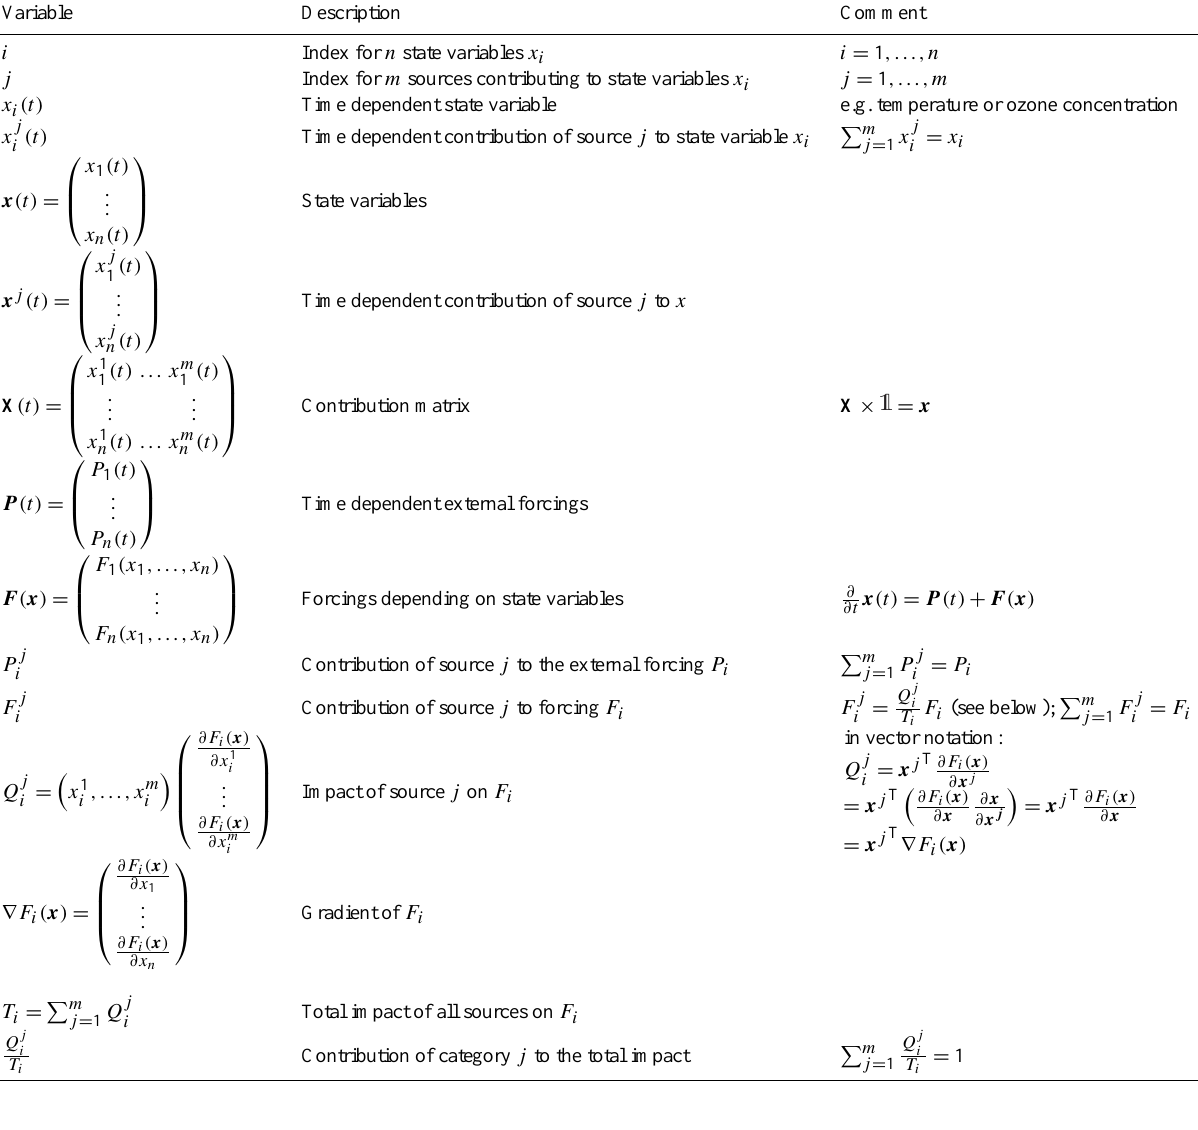
Table 1. Overview on used variables. The time dependency “ (t) ” is occasionally omitted for simplicity reasons, e.g. x (t) becomes x .